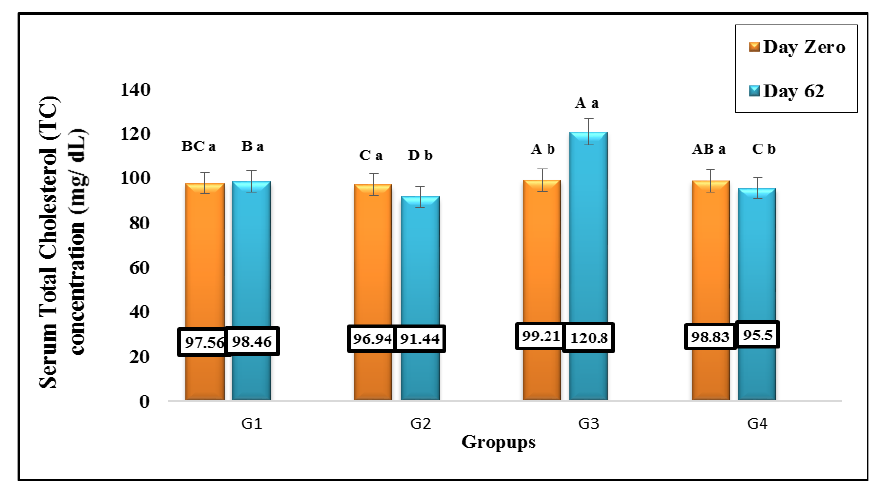
Figure 1. Effect of phosphatidylcholine, fructose and/or combination on serum total cholesterol concentration (mg/dL). Mean ± SE, n = 9 in a group. G1 control groups (C), G2: (Pc), G3: (Fr), G4: (Fr + Pc). A-C Significant variations P ≤0.05 between peroids